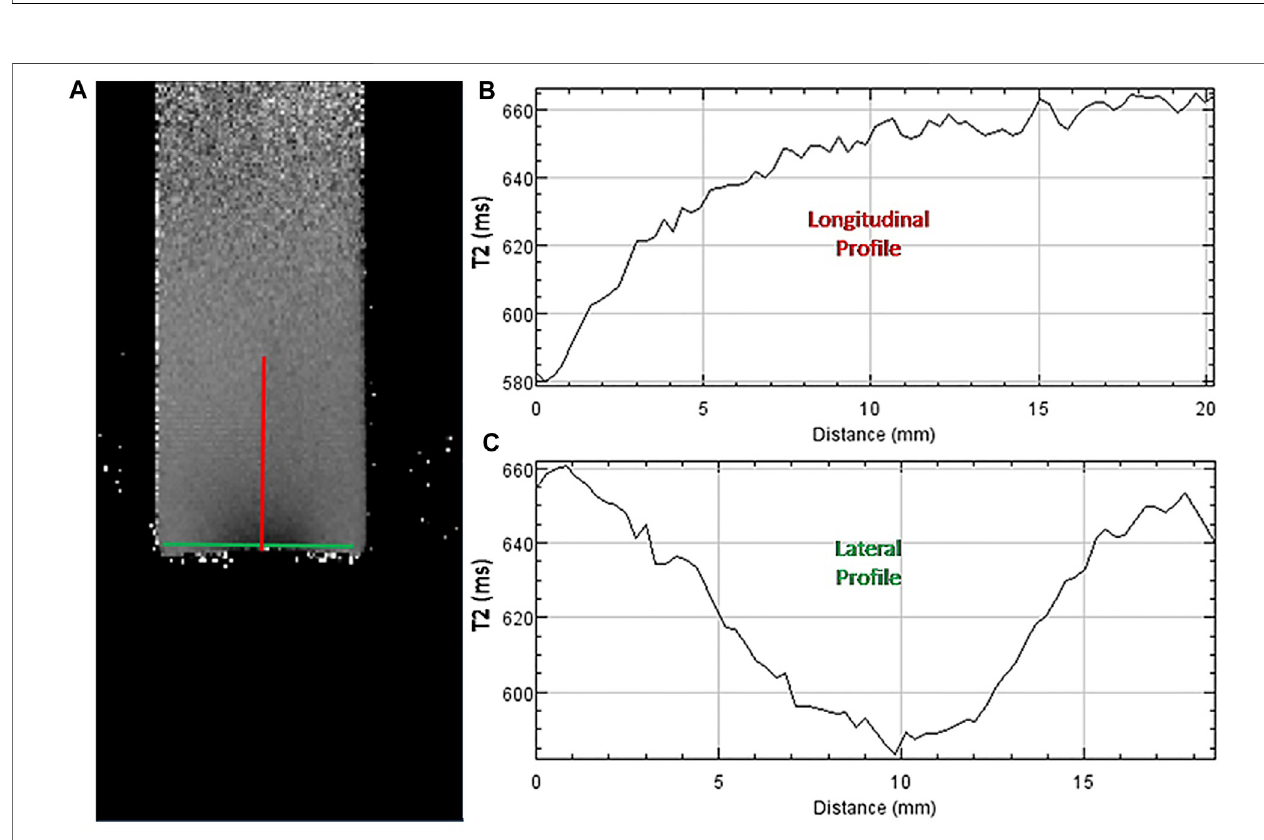
FIGURE 11 | (A) : T2 parametric map of the “ bottom to top ” irradiated vial of Figure 11B in greyscale NIH palette range: 500 – 700 ms. (B) : T2 values (ms) longitudinal pro fi le for a 2 cm length along the red line in panel A. (C) : T2 values (ms) lateral pro fi le for a 1.8 cm length along the green line in panel A.